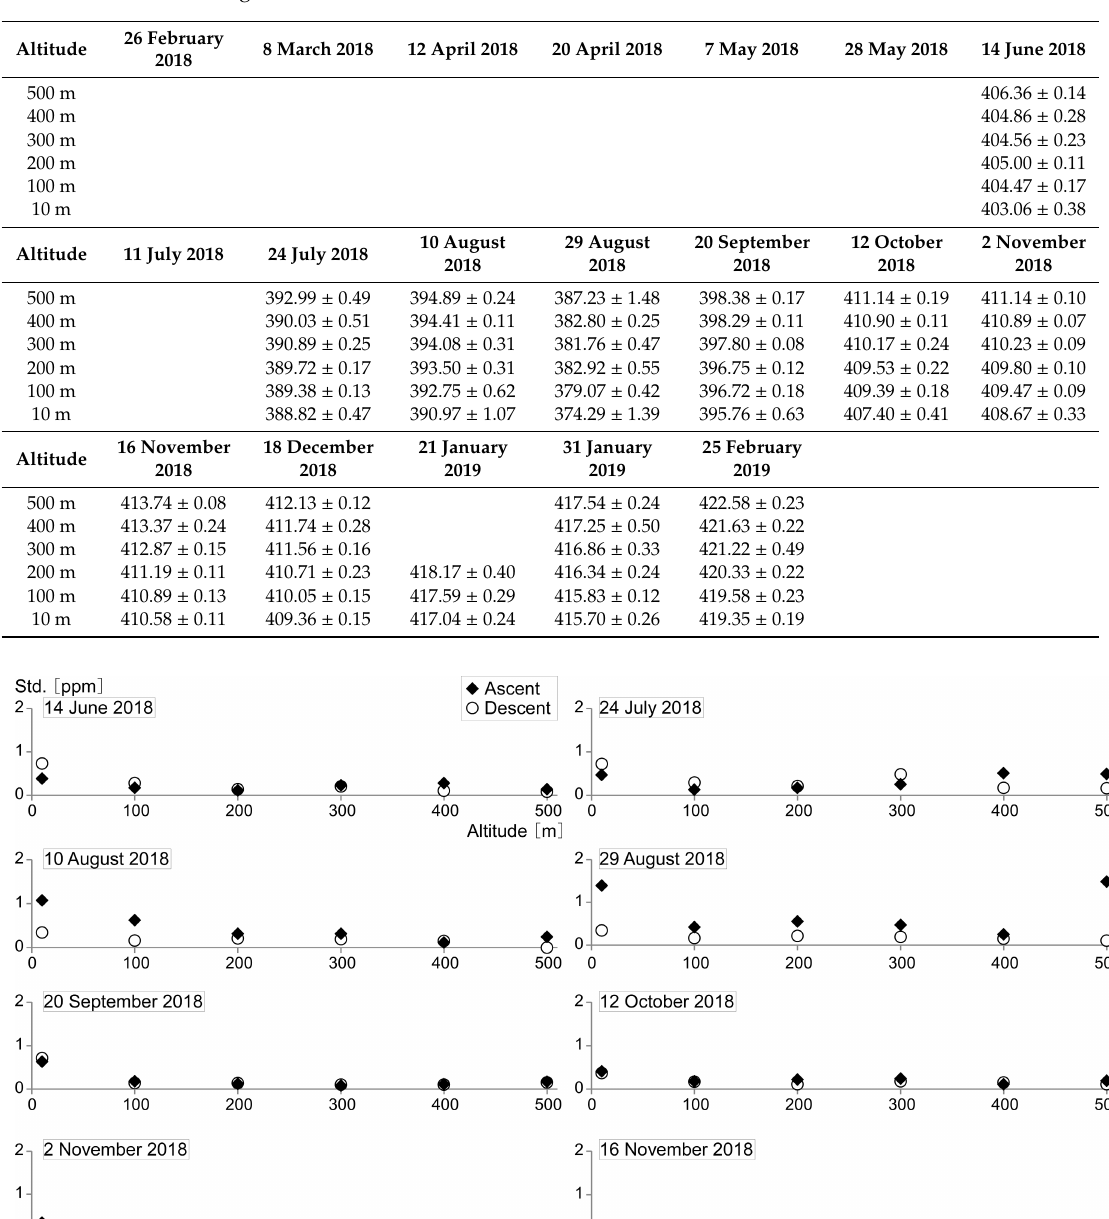
Table A4. CO 2 concentrations (mean ± standard deviation) in ppm, measured by the UAV system at each altitude during its ascent from winter 2018 to winter 2019.